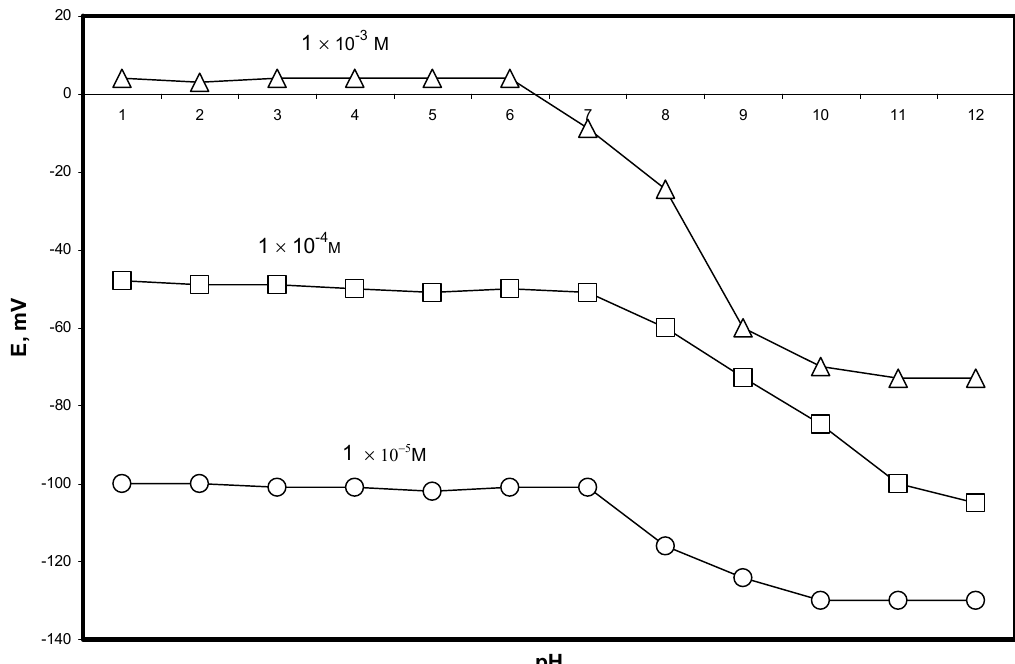
Figure 2.b. Effect of pH on the response of AC-PM membrane sensor using three series of AC solution 1 × 10 -3 , 1 × 10 -4 and 1 × 10 -5